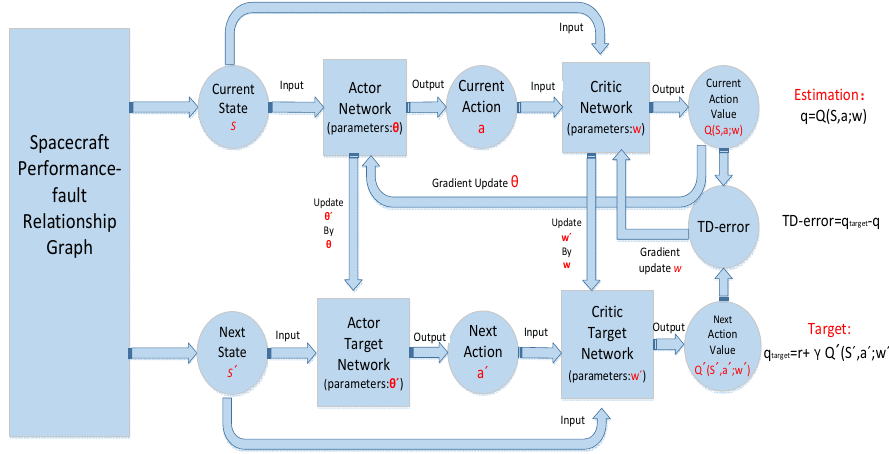
Figure 2. The structure of DDPG model.